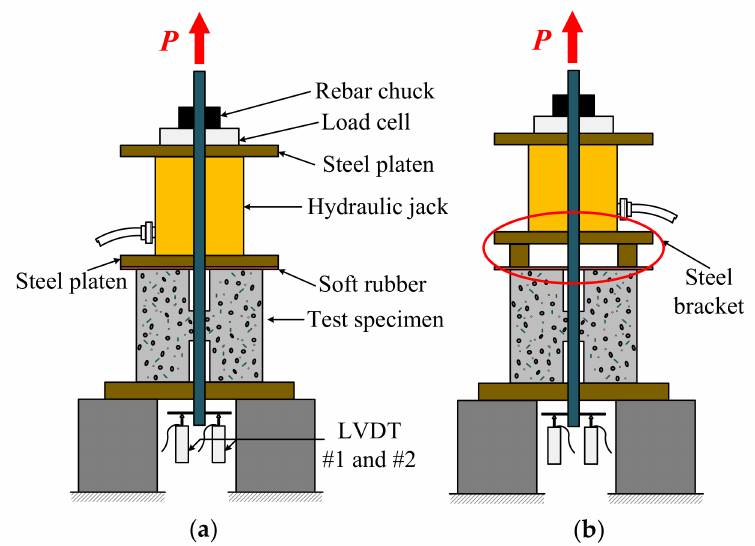
Figure 5. Pull-out test setup: ( a ) traditional pull-out; ( b ) revised pull-out. The tensile load was applied with a step of 2 kN until ultimate load, then a displace- ment load of 0.2 mm was applied per level until the slip reached 20